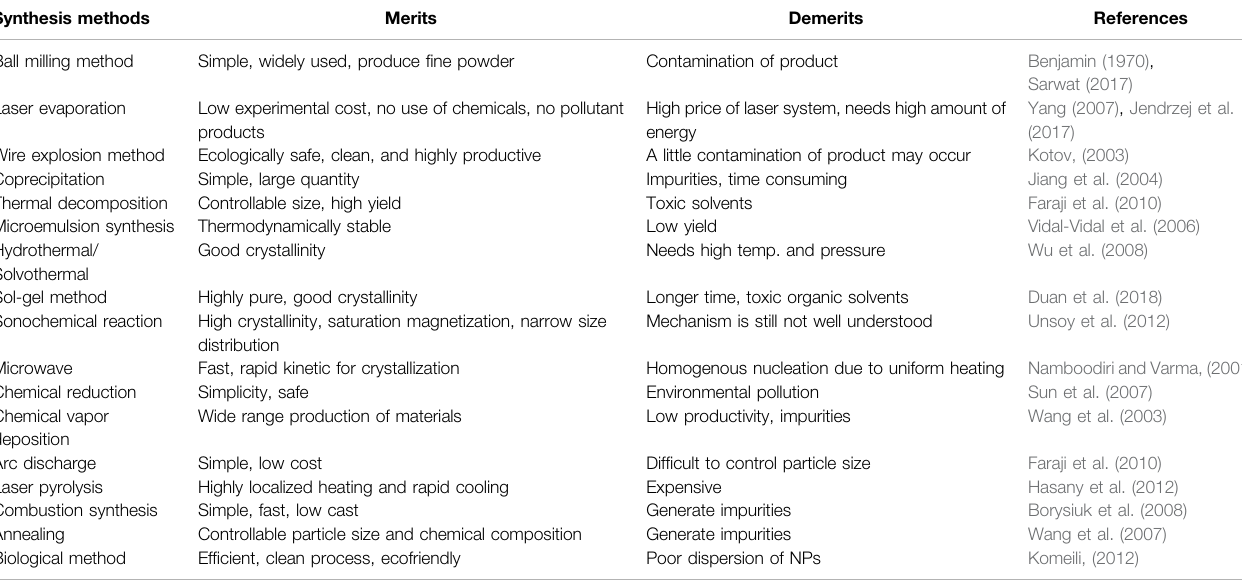
TABLE 1 | Different synthesis methods of MNPs with respective merits and